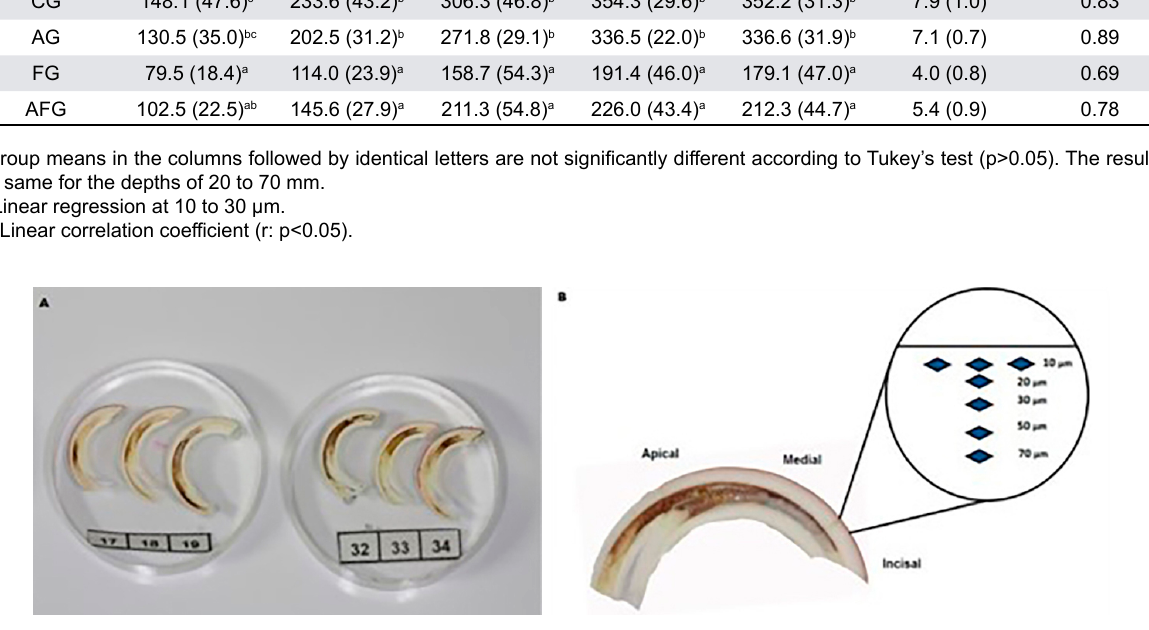
Figure 2- Rat teeth organized for hardness